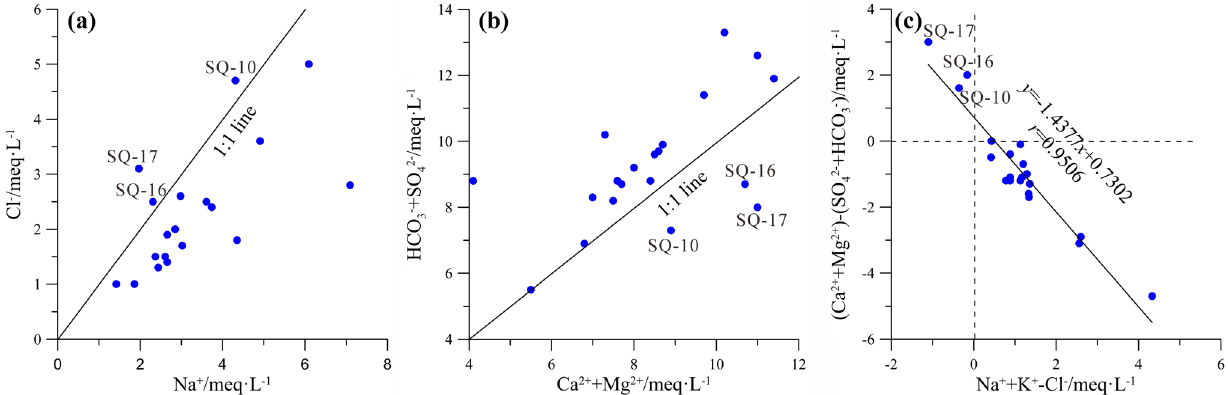
Fig. 5 Bivariate diagrams of major ionic concentrations in groundwater samples